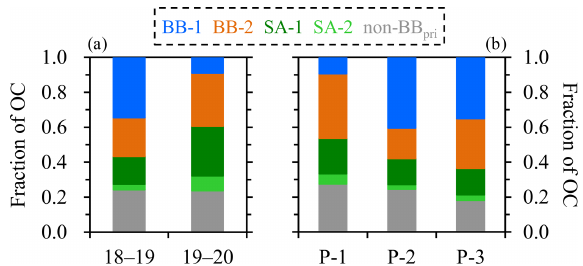
Figure 2. Comparison of OC source apportionment results (a) be- 2018–2019 samples collected before (P-1), during (P-2) and after (P-3) the legitimate burning